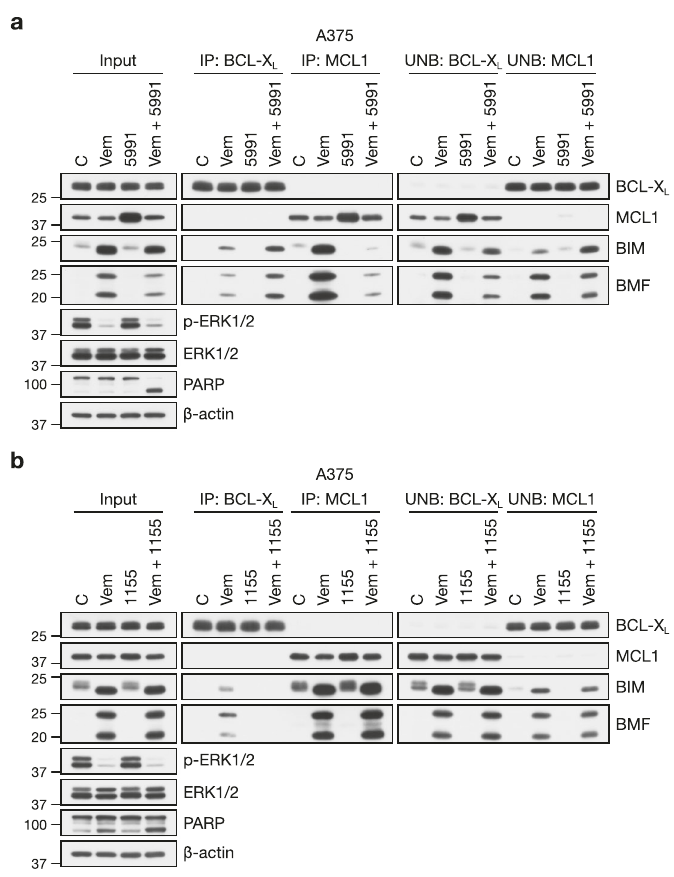
Fig. 7 Combined BRAFi and MCL1i redistributes BIM and BMF to other pro-survival proteins. a A375 cells were treated with DMSO vehicle-only (C and 5991) or 2 μ M vemurafenib (Vem and Vem + 5991) for 24 h followed by DMSO-only (C and Vem) or 1 μ M AZD5991 (5991 and Vem + 5991) for a further 4 h. Lysates (input) were subjected to immunoprecipitation with antibodies to BCL-X L or MCL1. Input lysates, immunoprecipitates (IP) and supernatant unbound fractions (UNB) were then western blotted using the indicated antibodies. b A375 cells were treated with DMSO vehicle-only (C and 1155) or 2 μ M vemurafenib (Vem and Vem + 1155) for 24 h followed by DMSO-only (C and Vem) or 0.1 μ M A-1155463 (1155 and Vem + 1155) for a further 4 h. Lysates (input) were subjected to immunoprecipitation with antibodies to BCL-X L or MCL1. Input lysates, immunoprecipitates (IP) and supernatant unbound fractions (UNB) were then western blotted using the indicated